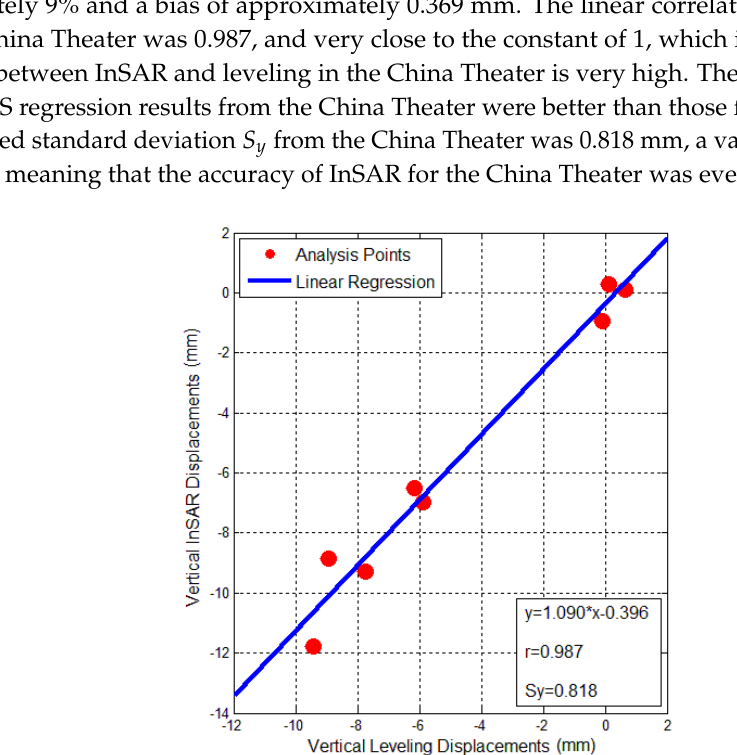
Figure 13. Measurement error between the extracted InSAR displacement and the truth leveling data in the China Theater, bigger column correspond to larger error.